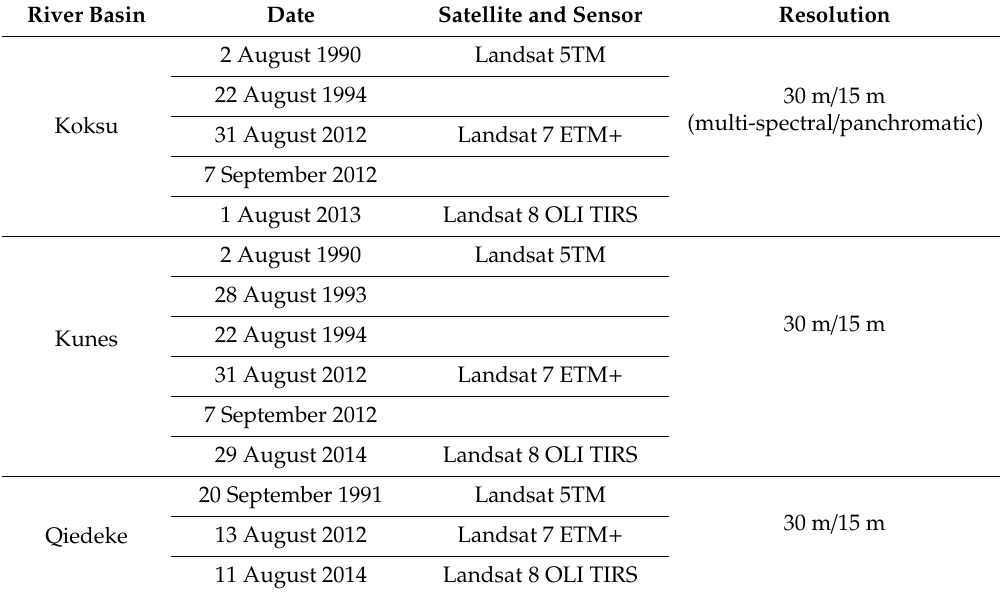
Table 2. Satellite imagery used in this study. Source: United States Geological Survey Global Visualization Viewer